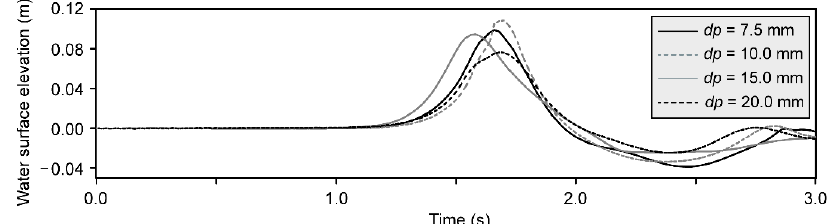
Figure 3. Convergence test: wave profiles at 2.00 m along the slide axis for different particle spacings dp in scenario 2.